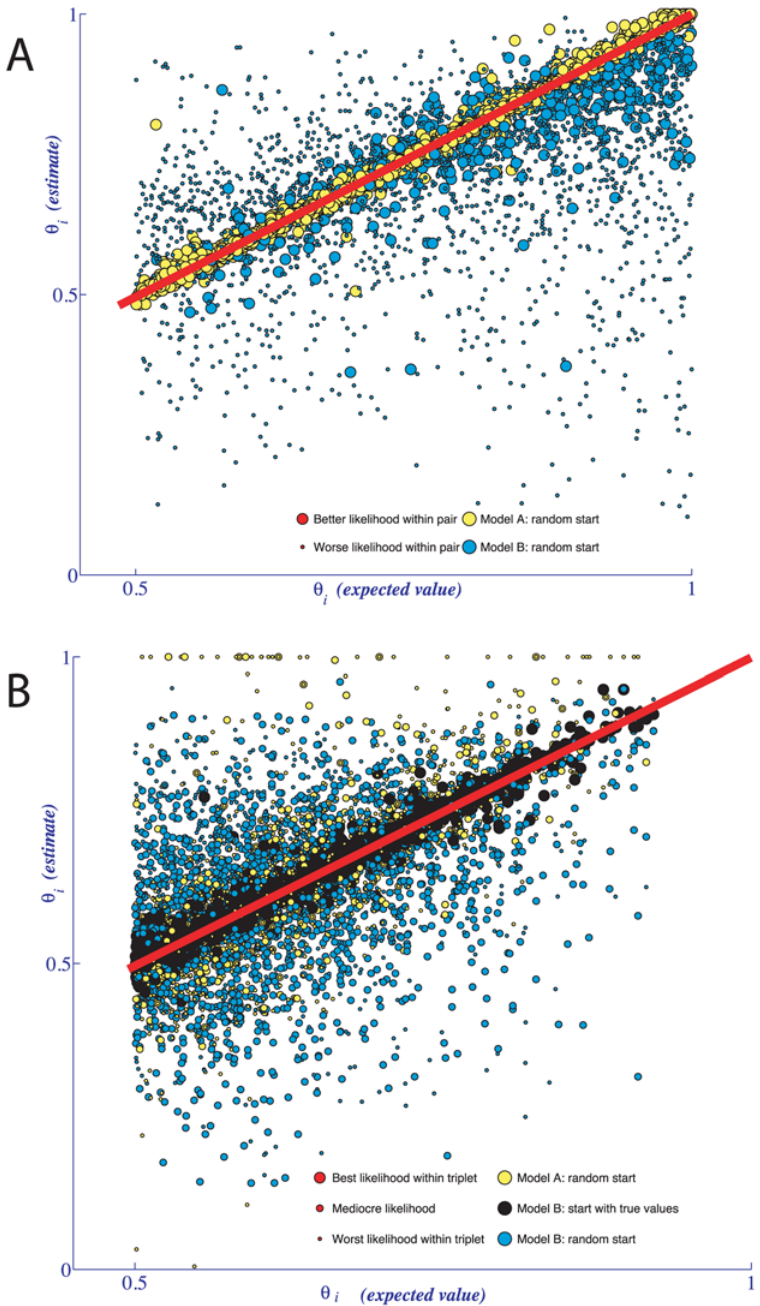
Figure 3. Simulation-estimation experiments assuming Model A (A) and Model B (B). We performed 1,000 6 2 computational experiments to generate annotation data under Model A (plot A) and under Model B (plot B), estimating parameters under both models in each case. Each of the 1,000 iterations per plot involved sampling a new set of the expected parameter values, generating artificial annotations using these expected values, and then estimating parameters from these artificial data. In each simulation iteration we generated 10,000 sets of artificial annotations imitating work of three annotators. Note that although Model B was not defined in terms of annotator-specific correctness parameters, these parameters can be expressed easily as a function of the native parameters of Model B. (A) Simulations under Model A: For each simulated data set we produced two different estimates, one with Model A and one with Model B. Model A estimation, starting with a random set of initial values with correctness parameter values . 0.5 each, reliably recovered the correctness parameter values (yellow dots). Estimation under Model B (blue dots) yielded a significantly wider scatter of estimates, most likely because the hill-climbing algorithm used in this estimation got stuck in one of the numerous local optima on the surface of posterior probability under Model B. Each round of parameter estimation produced two sets of three-annotator-specific estimates, resulting in 6 plot data points. (B) Simulations under Model B: For each of the 1,000 simulated data sets we produced a triplet of estimates (random starts under Models A and B, and start under Model B at the expected values of parameters). When started in the global-optimum mode (black dots), estimation of Model B reliably resulted in near-perfect estimates of the correctness parameters, outperforming the estimated parameters for Model A (yellow dots). However, when started with random parameter values for estimating under Model B, the estimates were widely scattered (blue dots), corresponding to the numerous local optima associated with Model B. Each estimation round resulted in three sets of three-annotator- specific estimates, represented as 9 separate data points in the plot.